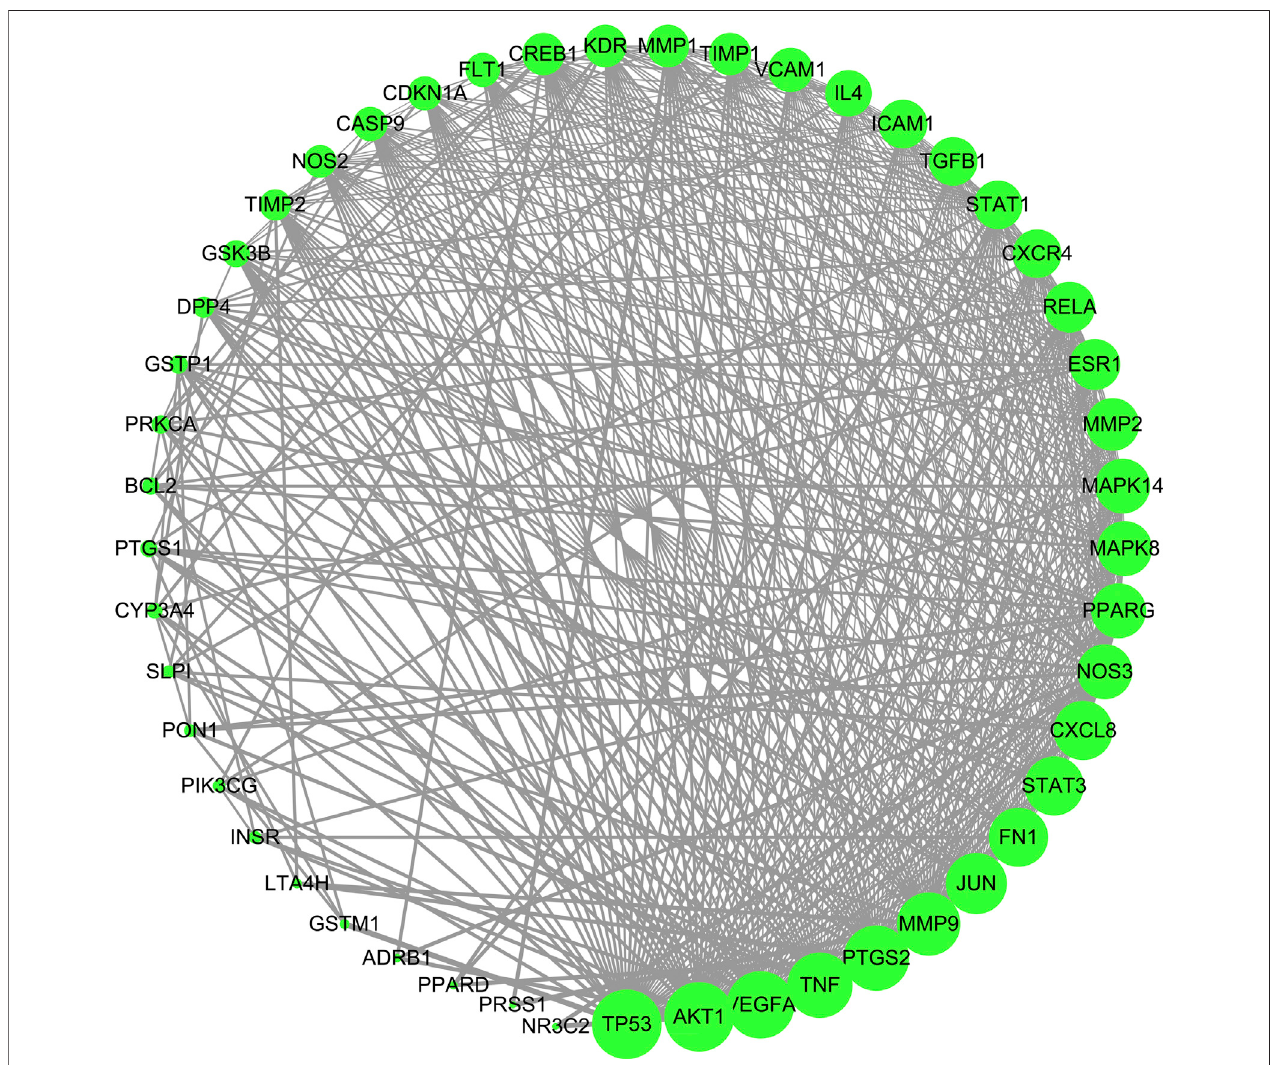
FIGURE4| PPInetworkofTWtreatingDN.Nodedegreeispositivelycorrelatedwithnodesize.Thelargerthenodeis,thegreaterthenodedegreevalueis,andthe more likely it is to play a role through the target.